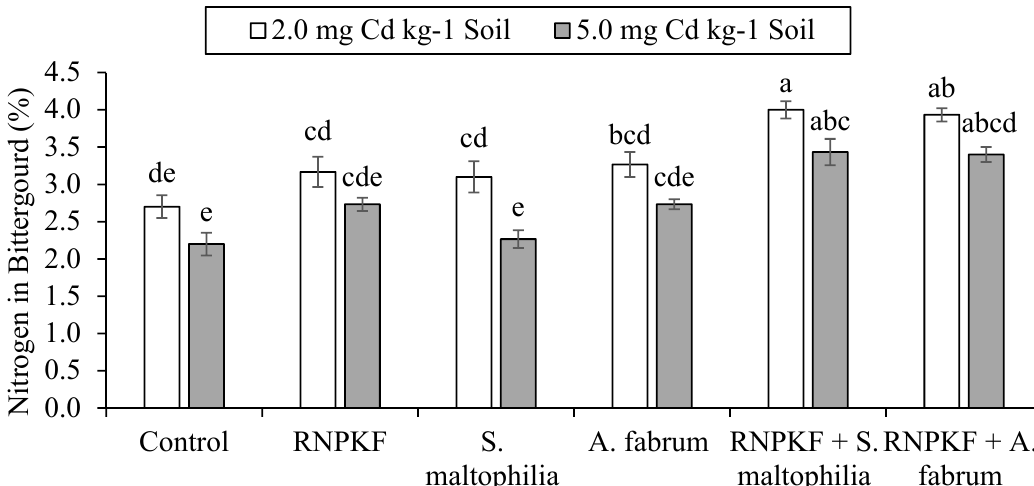
Figure 9. Nitrogen concentration in bitter gourd (%) treated with PGPRs, RNPKF, and their combination under 2 and 5 mg Cd kg − 1 soil. Different small letters express significant differences ( p ≤ 0.05).